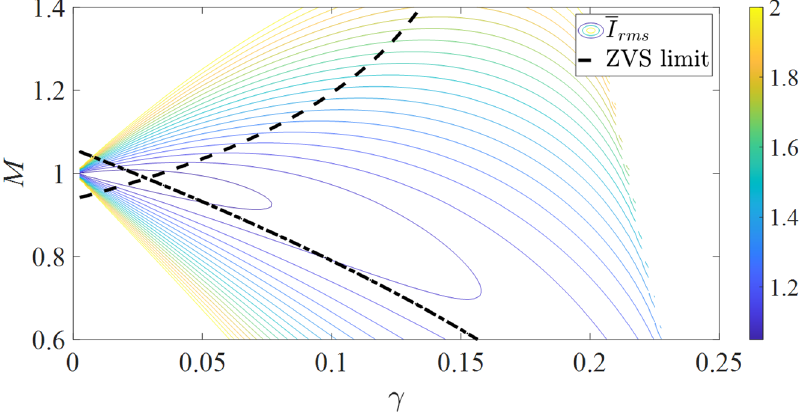
Figure 4. Normalized RMS current mapping of DAB under single phase-shift modulation including ZVS regions.